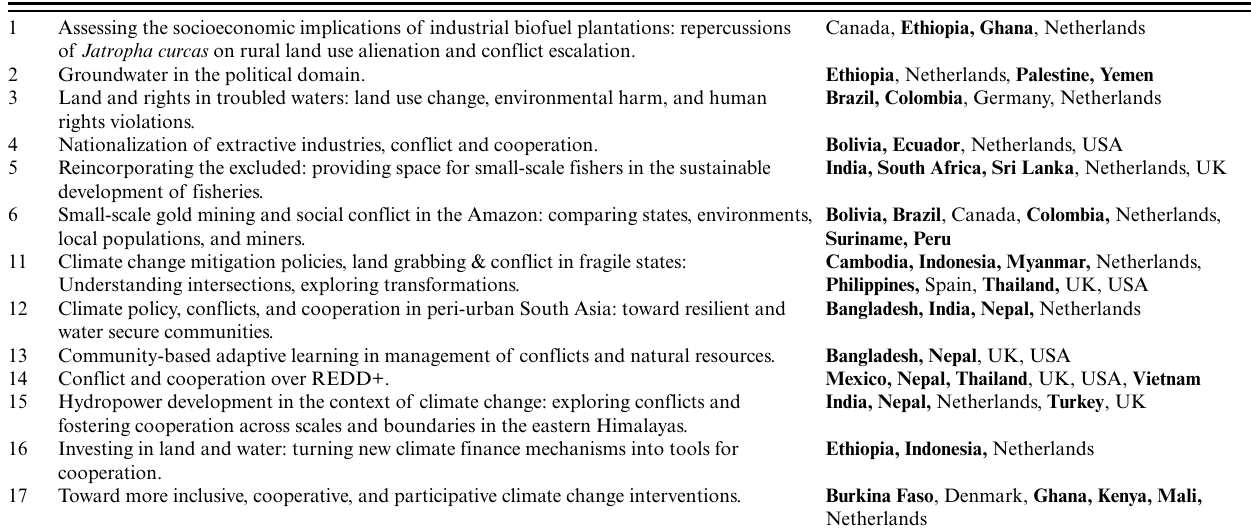
Table 1 . CoCooN and CCMCC Projects. Project number, project name, countries of the team members.